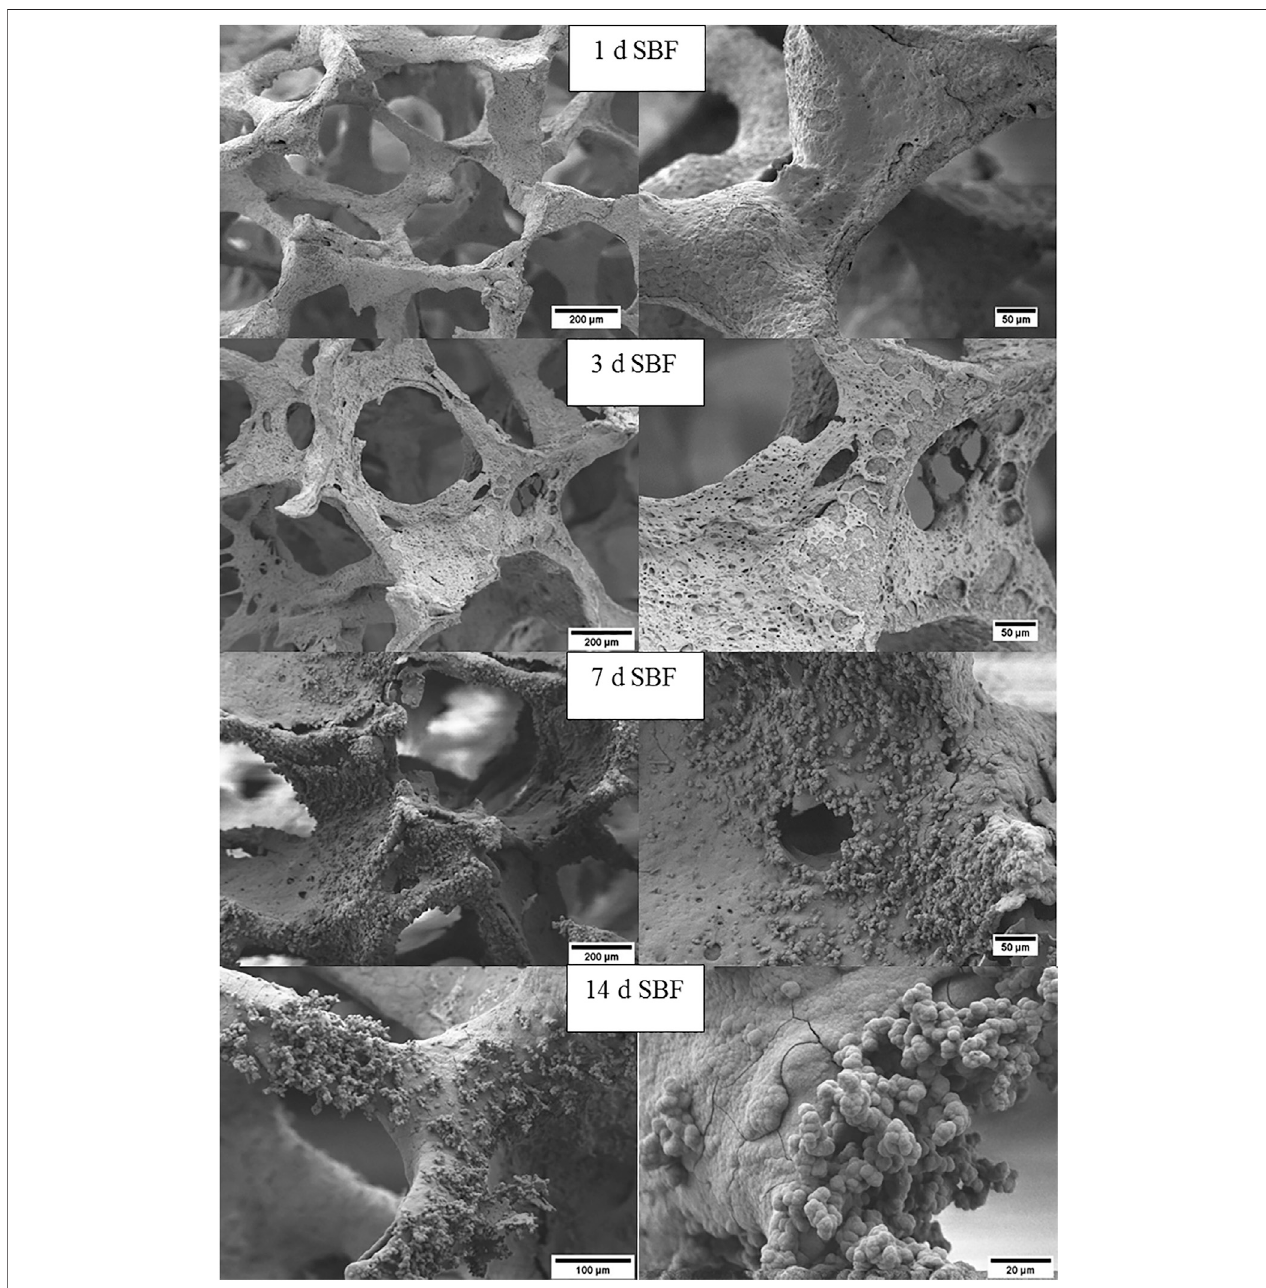
FIGURE 5 | SEM images at different magni fi cations of zein+MH coated BG scaffolds after immersion in SBF for 1, 3, 7, and 14 days.